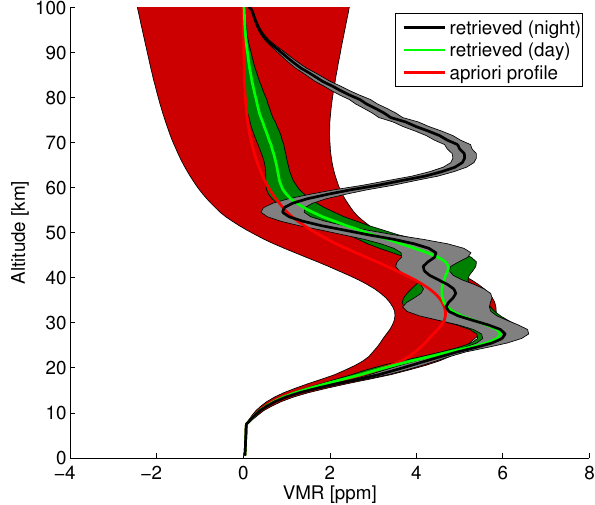
Fig. 4. O 3 profiles retrieved during night (black) and day (green) and the a priori profile (red). The spectrum shown in Fig. 3 cor- responds to the night time spectrum. The shaded regions (green, black) are the uncertainties caused by the total error as derived in Sect. 2.6. The red shaded region is the a priori standard deviation used in the